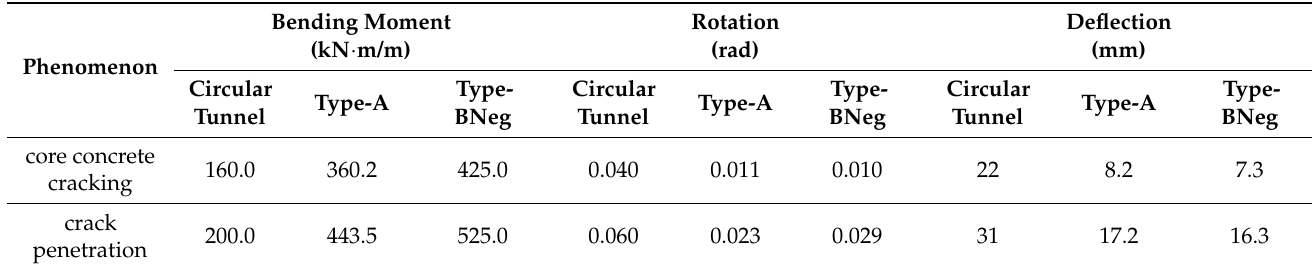
Table 5. Comparison between the joints with DIJPs and joints in a conventional circular tunnel in negative cases.